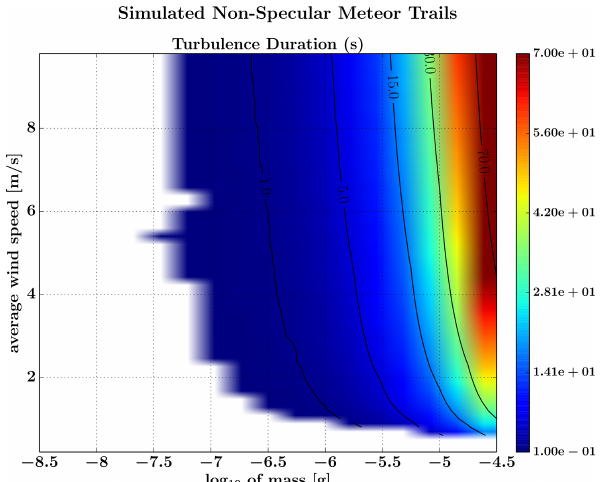
Figure 4. Minimum neutral winds vs. meteoroid mass. Notice that neutral winds smaller than 0.6ms − 1 do not create non-specular me- teor trail echoes (i.e. plasma instabilities cannot be sustained in the